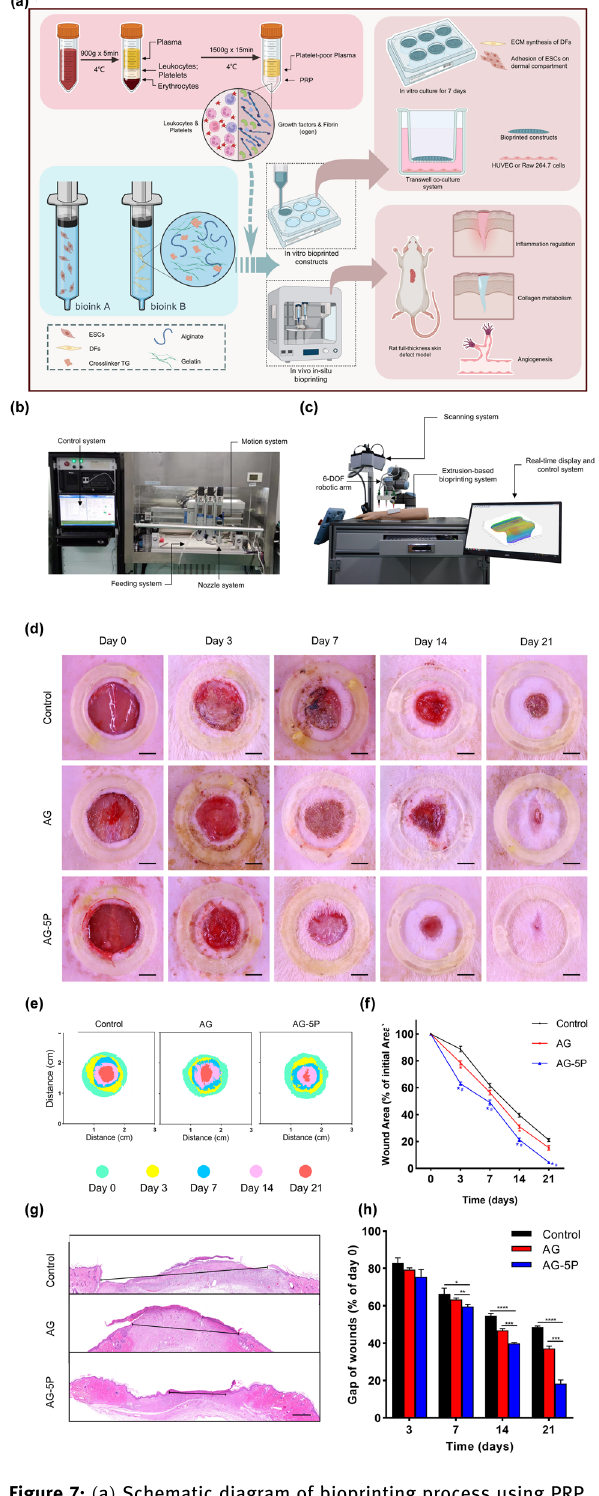
( scale bar is 5 mm ) . ( e ) Images of wound closure in 21 days. Di ff erent colors represent the wound size at di ff erent times. ( f ) The wound area changes in 21 days. ( g ) Images of HE staining of the wound on day 21. ( h ) Quantitative results within 21 days. Reproduced with permission from Zhao et al. [ 112 ]